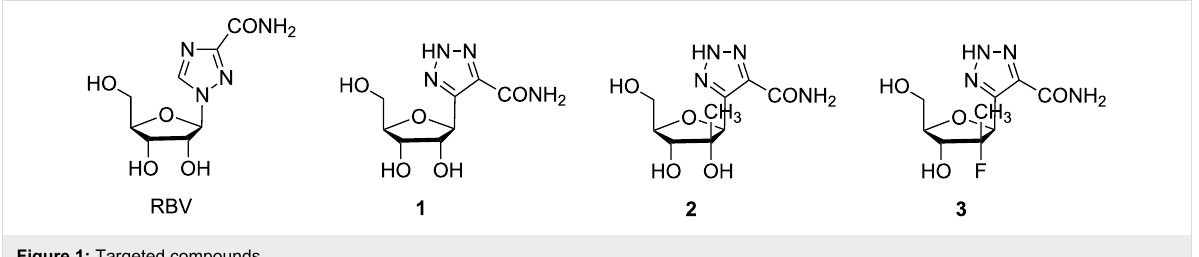
Figure 1: Targeted